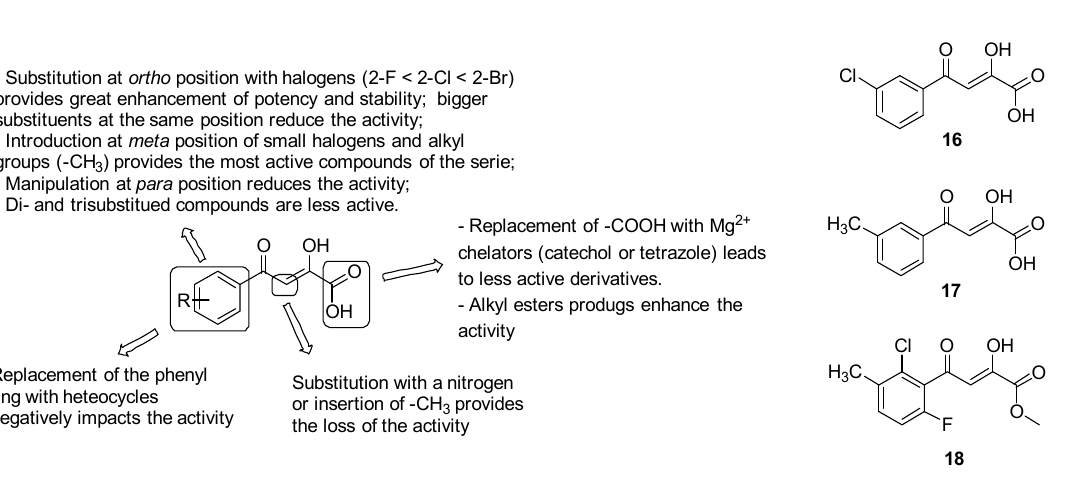
Figure 25. SARs of PDKAs and chemical structures of compounds 16, 17, and 18.